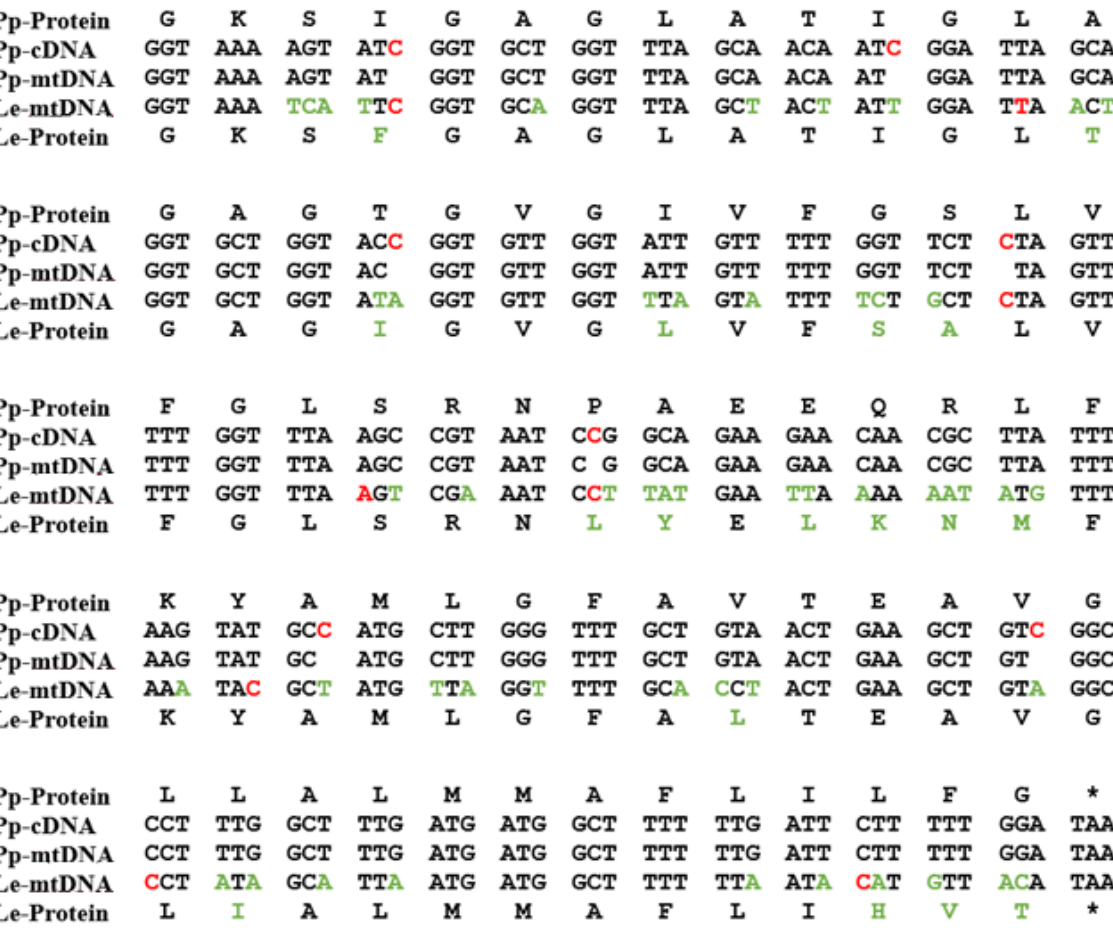
Figure 2. A portion of the atp9 gene on the mtDNA of P. polycephalum (Pp-mtDNA) and Lycogala epidendrum (Le-mtDNA) aligned with P. polycephalum cDNA (Pp-cDNA) and the inferred protein products using the classic genetic code. The alignment shows the editing site distribution and variation in editing site locations in different myxomycetes. Red letters in Pp-cDNA are experimentally determined RNA editing sites in P. polycephalum. Red letters in Le-mtDNA are RNA editing sites inferred by alignment. Green letters in Le-mtDNA and Le-Protein show differences between the P. polycephalum and L. epidendrum sequences. * indicates termination codon.